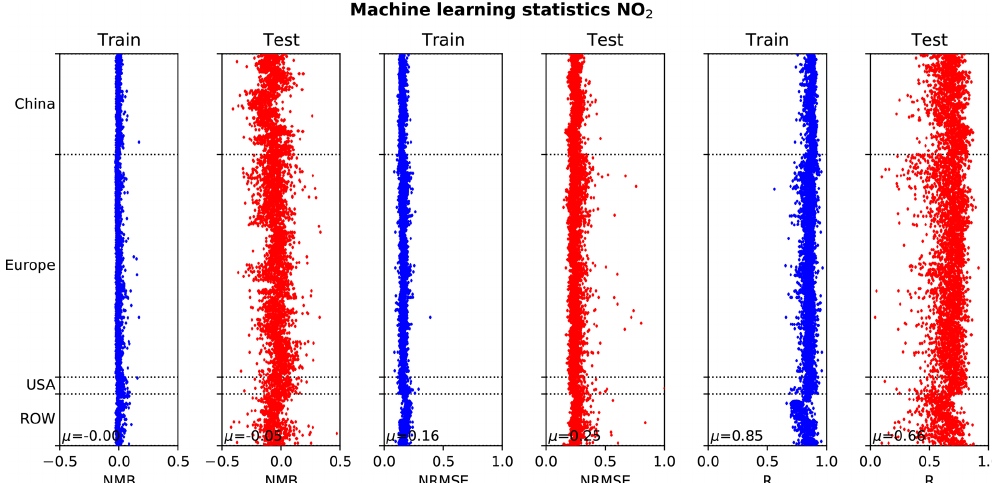
Figure 2. Machine learning statistics between hourly observations and the corresponding bias-corrected model predictions for each observa- tion location. Shown are the normalized mean bias (NMB), normalized root-mean-square error (NRMSE), and Pearson correlation coefficient ( R ) for the training data (blue) and the test data (red). Data are sorted by region: China, Europe, United States (USA), and rest of the world (ROW). The mean values across all locations are shown in the figure inset.